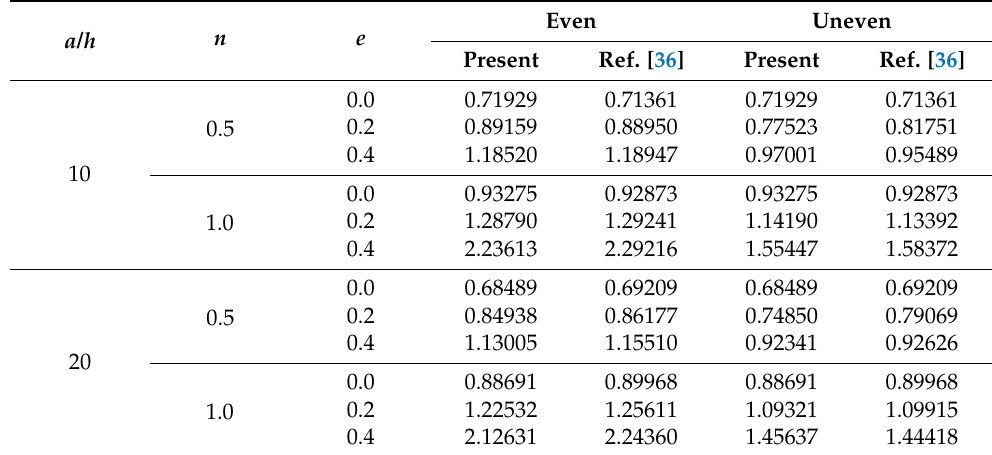
Table 2. The calibrated central deflections w of simply supported square FG porous